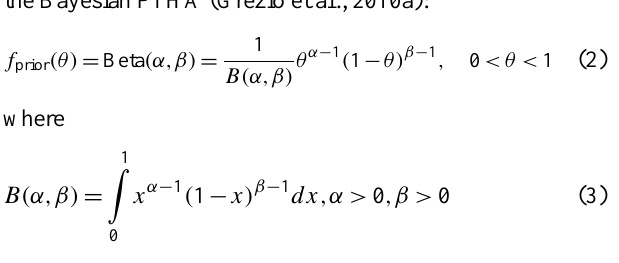
we computed an extensive set of run-ups Z using the conti- nental slope angle of an average slope computed in a reason- able area in front of Messina